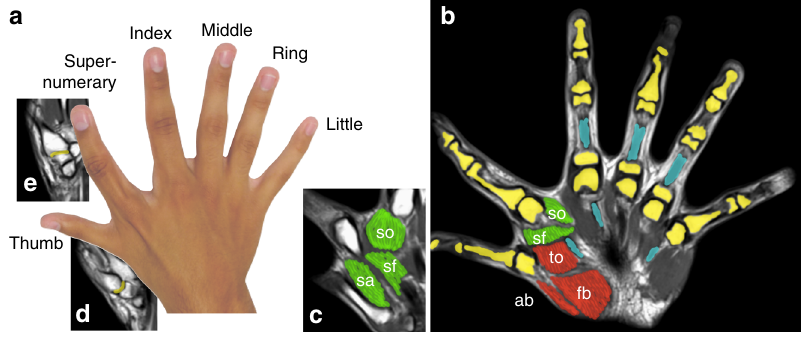
Fig. 1 The right hand ’ s anatomy of subject P1. A photo of the dominant right hand of one of the six- fi ngered subjects ( a ). The joints of the wrist (radio-ulnar, radio-carpal and mid-carpal) are similar to that of a normal fi ve- fi ngered hand ( b ). Bones are in yellow, tendons in blue, muscles: so,sf,sa: supernumerary fi nger opponens, fl exor, abductor; to: thumb opponens; ab: abductor pollicis brevis; fb: fl exor pollicis brevis. The four fi ngers from index to little have a similar skeleton, musculotendinous attachments and nerves as the corresponding fi ngers of a normal hand. The thumb resembles a normal thumb, with two phalanges. However, its carpometacarpal joint to the wrist ( d ) is of ball-and-socket type, with three degrees-of-freedom (dof) including torsion, while a normal thumb will have a saddle joint that does not allow torsion. The musculotendinous and neurovascular structures resemble the thumb of a normal hand ( b , d ). The sixth fi nger or supernumerary fi nger has three phalanges and a saddle carpometacarpal joint ( e ). It has two extrinsic fl exor tendons and a normal extensor apparatus not dissimilar to that of a tri-phalangeal digit. Interestingly, there are muscles whose origin is the second metacarpal and whose insertion is to the proximal phalanx of the fi nger ( b , c ), similar to the muscles of a normal thumb with spherical range of